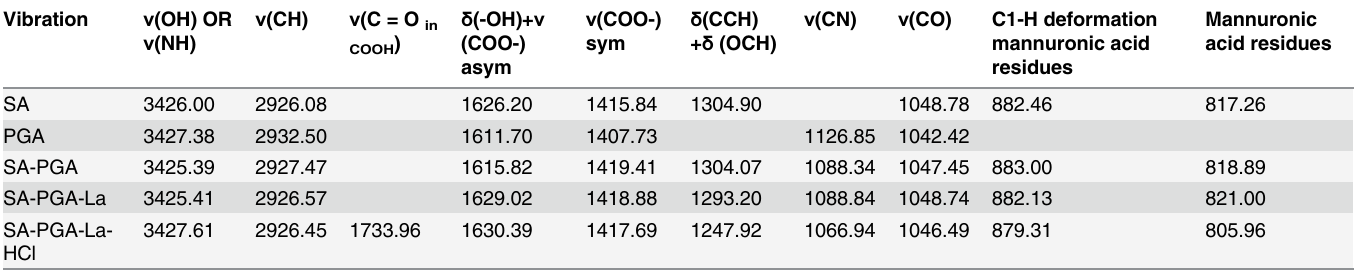
Table 1. Assignment of the main vibrational modes.(C HCl :0.1mol/L,50mL).